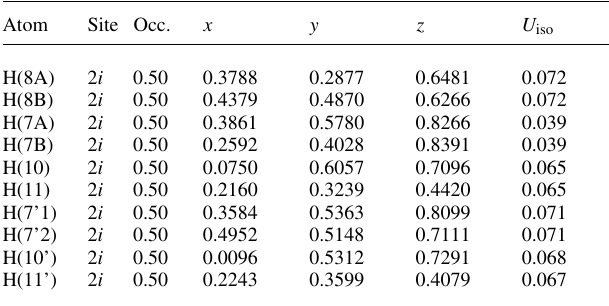
Table 2. Atomic coordinates and displacement parameters (in Å 2 )